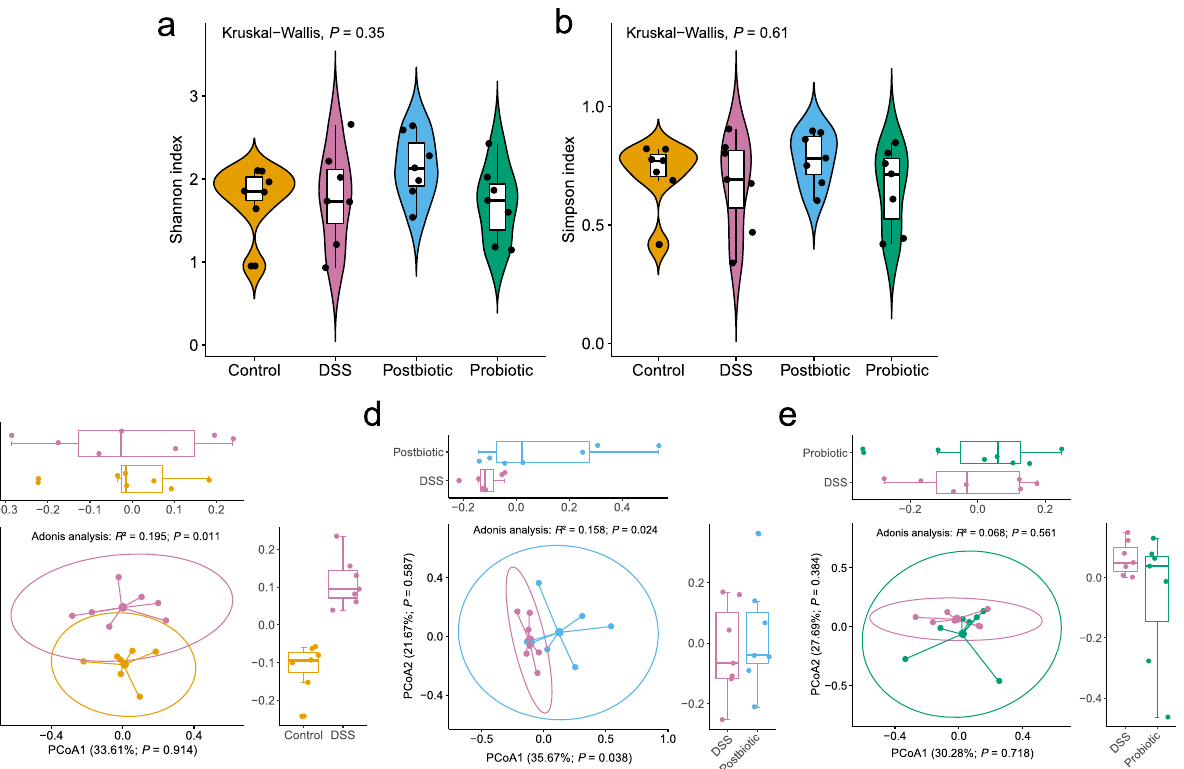
Fig. 2 Postbiotic but not probiotic regulated the gut microbiota diversity. Shannon index ( a ) and Simpson index ( b ) of the fecal microbiota of the Control, Dextran sulfate sodium (DSS), Postbiotic, and Probiotic groups. Principal coordinate analysis (Bray – Curtis dissimilarity) score plot of species-level fecal microbiota of the Control and DSS groups ( c ), Postbiotic and DSS groups ( d ), and Probiotic and DSS groups ( e ). In the boxplot, horizontal line represents the median of the data, lower and upper bounds of the box represent the 25th and 75th percentile of data, and the whiskers represent the minimum and maximum of the data. The scattered point on the box represents the actual data